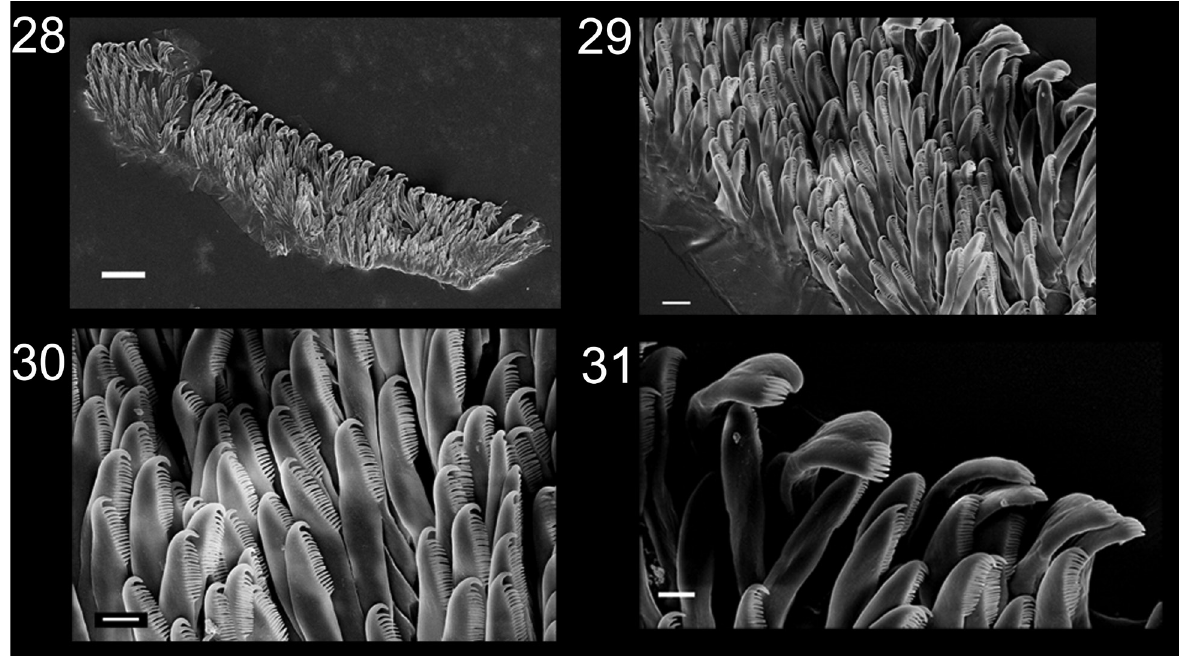
Figures 28–31. Actinocyclus verrucosus , radula in SEM. 28. Panoramic view, scale: 100 µm. 29. higher magnification in central region, scale: 40 µm. 30. Outer lateral teeth, scale: 10 µm. 31. Detail of marginal teeth tip, scale: 10